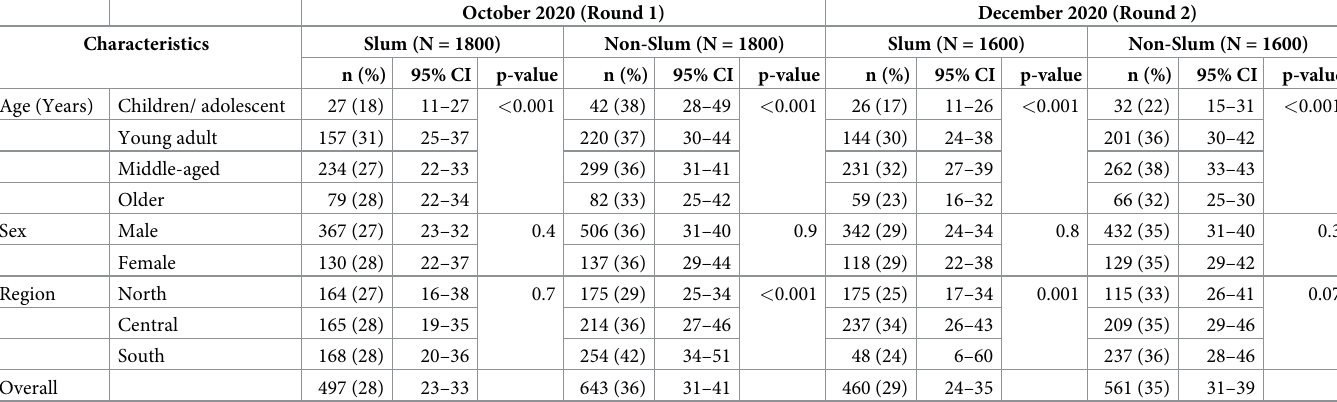
Table 1. Outdoor mask compliance in public places in the slum and non-slum areas by age group, gender, and region, Greater Chennai Corporation, Tamil Nadu, India, October & December